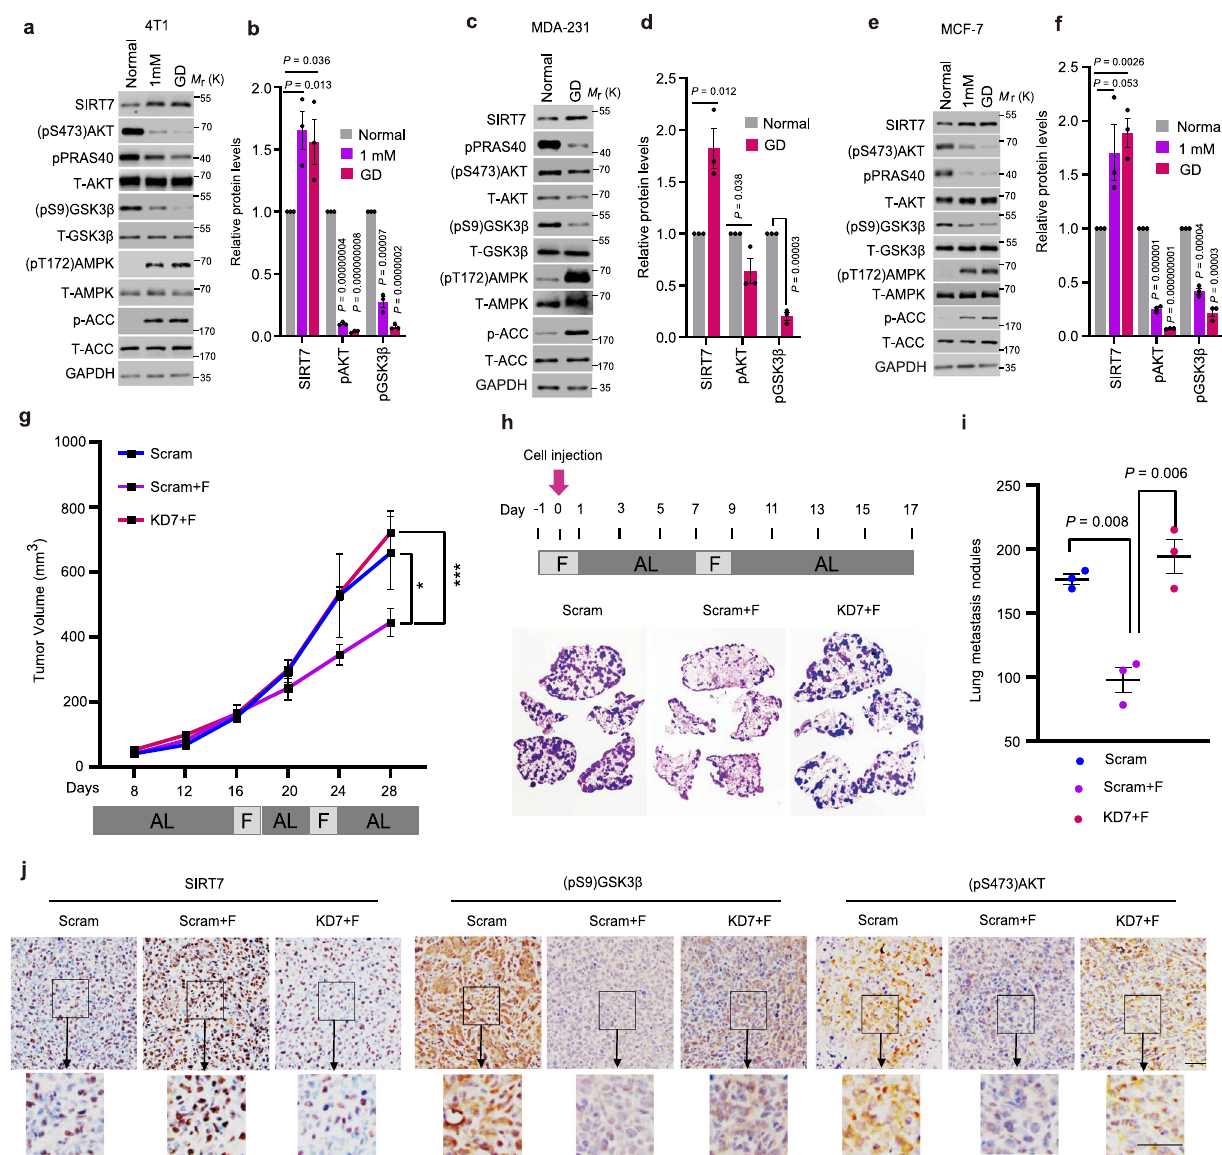
Fig. 1 Intermittent fasting inhibits tumor growth and metastasis via SIRT7. a – f Immunoblotting and quanti fi cation of protein levels in 4T1 murine mammary cancer cells ( a , b ), MDA-231 ( c , d ), and MCF-7 human breast cancer cells ( e , f ) cultured with the indicated doses of glucose for short-term treatment. The relevant quanti fi cations were collected from three independent experiments. g 4T1 cells stably transfected with Scramble (Scram) and Sirt7 knockdown (KD7) shRNAs were injected into the mammary fat pad of female Balb/c mice. Mice in the Scram + F and KD7 + F groups were subjected to intermittent fasting (IF) for 48 h from day 16 and day 22, respectively; otherwise, all animals were fed ad libitum ( n = 5 mice in the scramble group and n = 6 in each of the fasting groups). Tumor size was measured using Vernier calipers. h , i Scram and KD7-transfected 4T1 cells were injected into the tail vein of female Balb/c mice on day 0 (arrow) ( n = 3 mice in each group). Mice were subjected to IF as indicated; otherwise, animals were fed ad libitum. Lung metastatic tumor nodules were analyzed by H&E staining ( h ) and the number of nodules was counted in the whole lung ( i ). j Immunohistochemistry (IHC) staining showing the levels of SIRT7, (pS473)AKT, and (pS9)GSK3 β in tumor samples of Fig. 1g. Scale bar, 50 µ m. Data represent means ± SEM ( b , d , f , g , i ). P values were calculated by two-tailed Student ’ s t -test ( b , d , f , i ) or two-way ANOVA analysis ( g ), * P = 0.03, *** P = 0.0000002. Representative results were obtained from at least three independent experiments. Source data are provided as a Source Data fi (Supplementary Fig. 2a, b). GST-pulldown assays with recombi- nant GST-SIRT7 and His-GSK3 β proteins con fi rmed a direct interaction between SIRT7 and GSK3 β (Supplementary Fig. 2c).